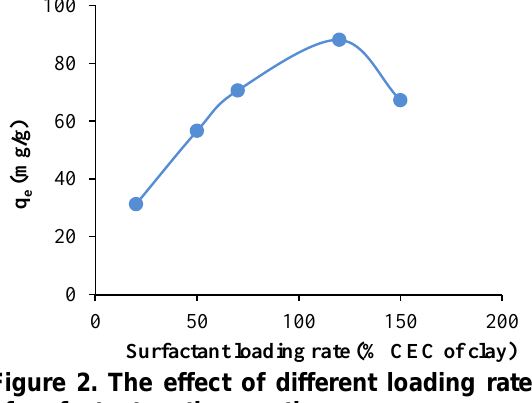
Figure 2. The effect of different loading rates of surfactant on the sorption Contact time = 24 hours; Bromocresol green (BCG) concentration = 100 mg/l; Adsorbent dosage = 1 g/l; pH =